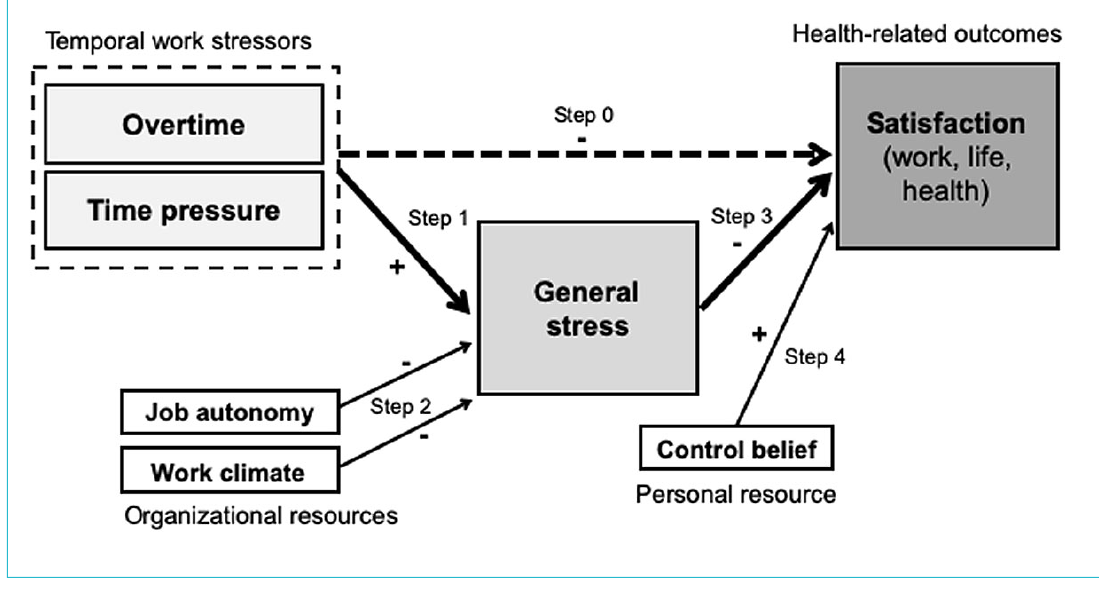
Figure 1: Explanatory model for the prediction of health and well-being among health professionals.